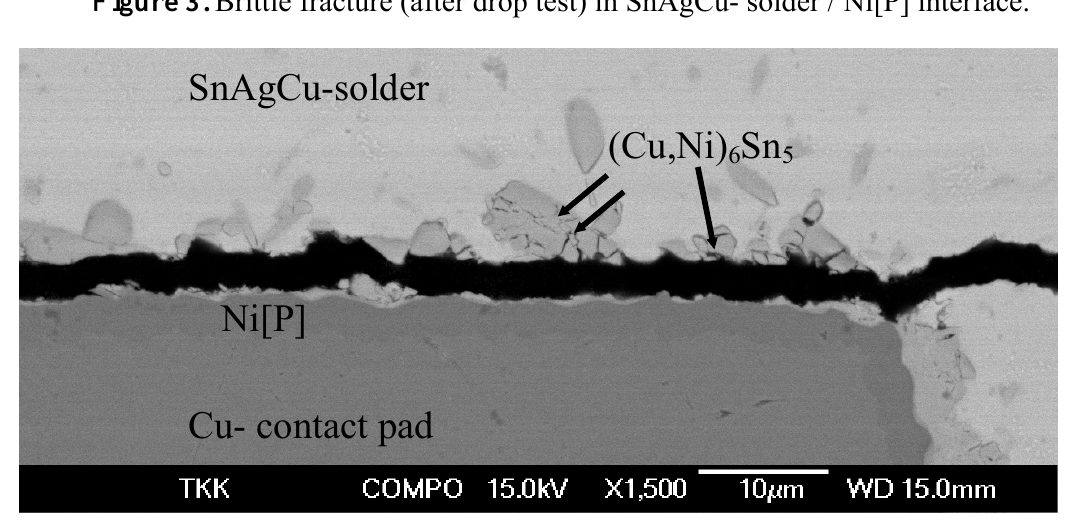
Figure 3. Brittle fracture (after drop test) in SnAgCu- solder / Ni[P] interface.